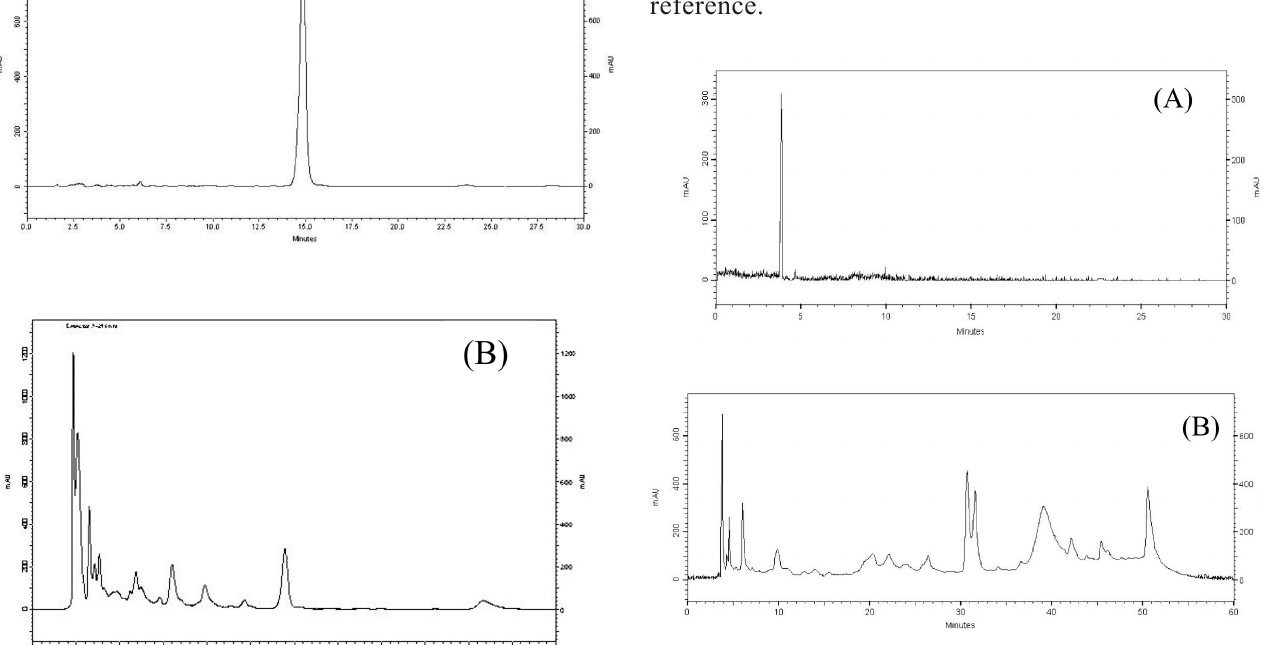
FIGURE 2 - HPLC/DAD chromatograms of santin, mAU x Time (min): (A) santin standard ; (B).spray-dried extract from feverfew. Mobile phase: solvent A (2% formic acid in water); solvent B (Acetonitrile). Gradient elution 0-10 min 15% B in A; 10-40 min 15-30% B in A and 40-50 min 30-15% B in A. Flow-rate: 0.8 mL/min. Detection at 241